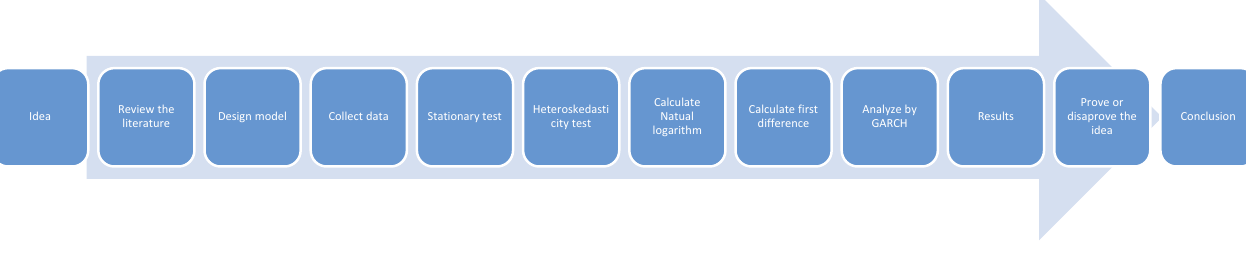
Fig. 2. Flowchart of the research methodology.